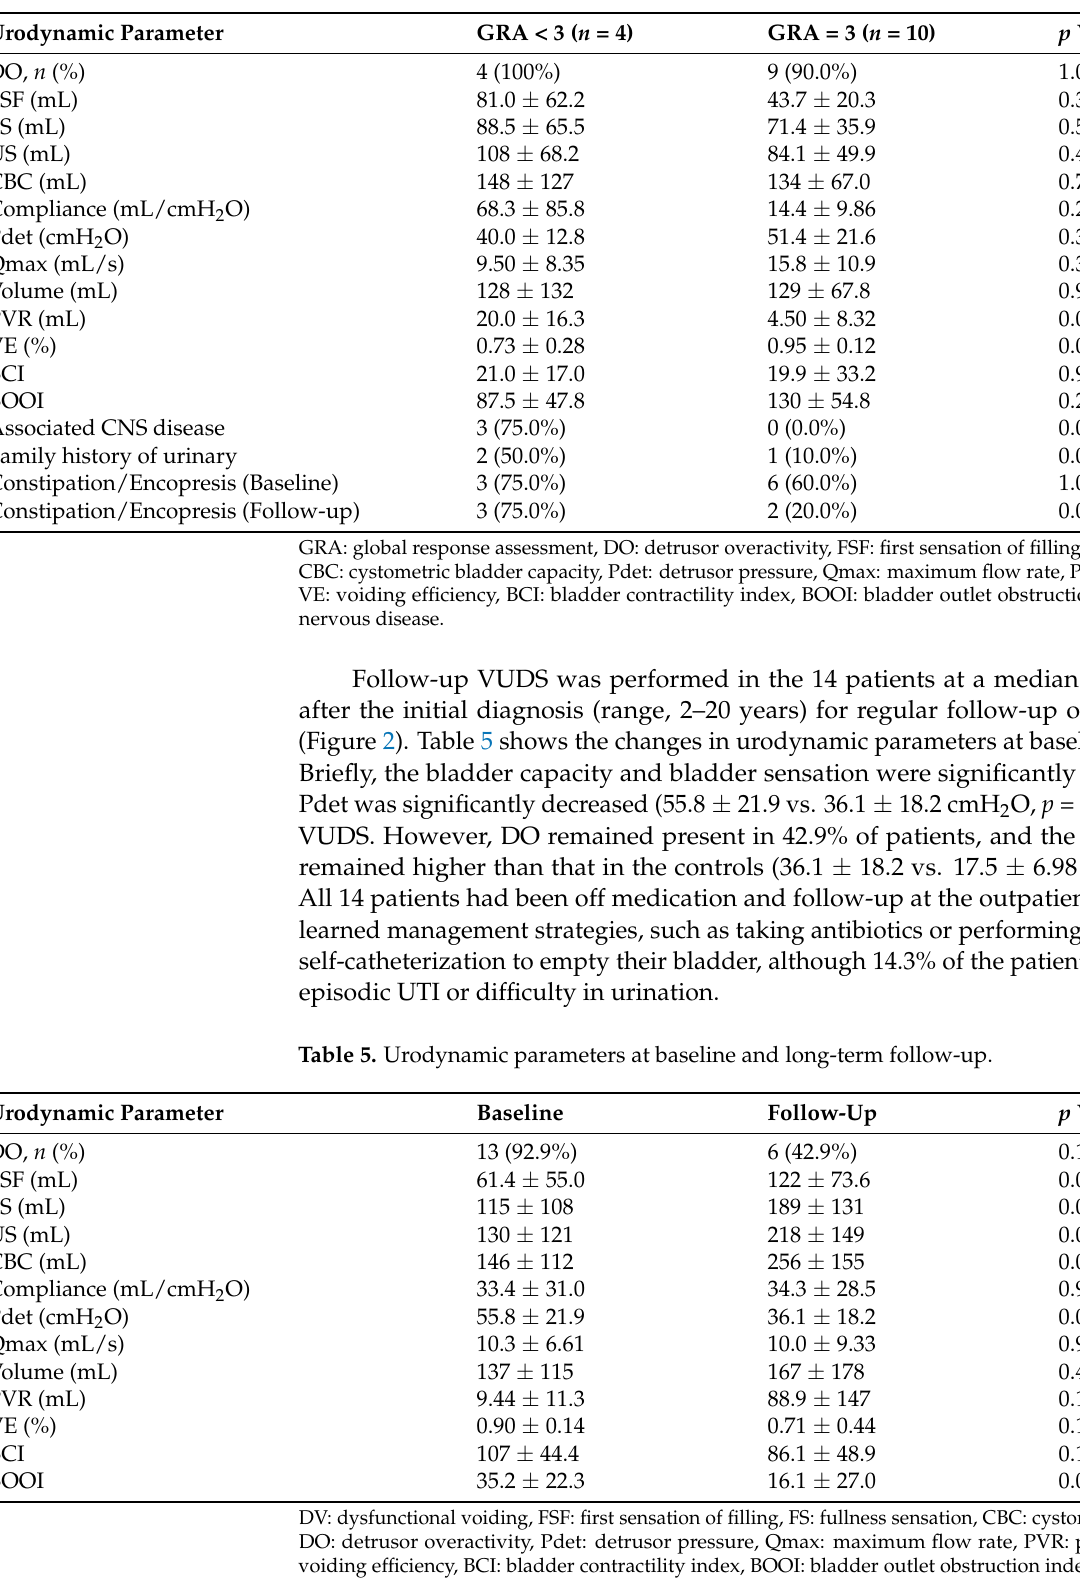
Table 4. Urodynamic parameters at baseline between satisfied and unsatisfied patients.